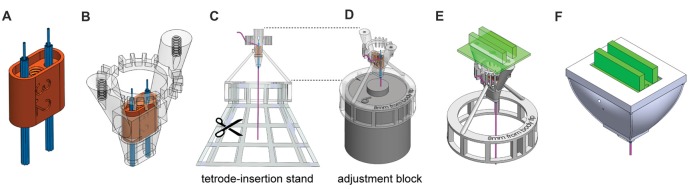
Steps of HOPE-implant construction. (A) Insertion of the two polyimide-tube bundles into the shuttle. (B) Insertion of the shuttle into the body. (C) Insertion and cutting of the tetrodes. (D) Leveling of tetrode lengths. (E) Addition of the drive system (screw and bar) and the EIB. (F) Encapsulation of the implant.